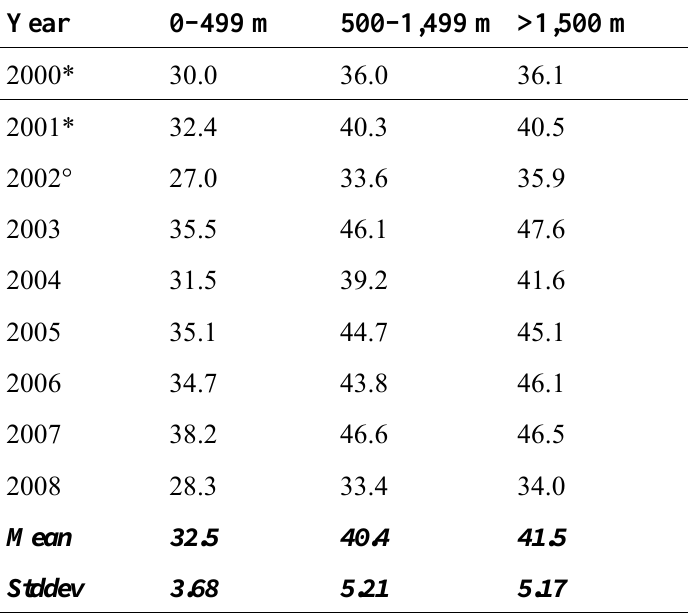
Table1. Spatial distribution analysis of good quality pixels in daily MODIS LST after applying all filters with respect to altitude. The values indicate the percentage of “good” pixels (*: only observations from MODIS on Terra satellite; °: MODIS on Aqua data only available from 8 July 2002). The overall number of input maps is 11,179.